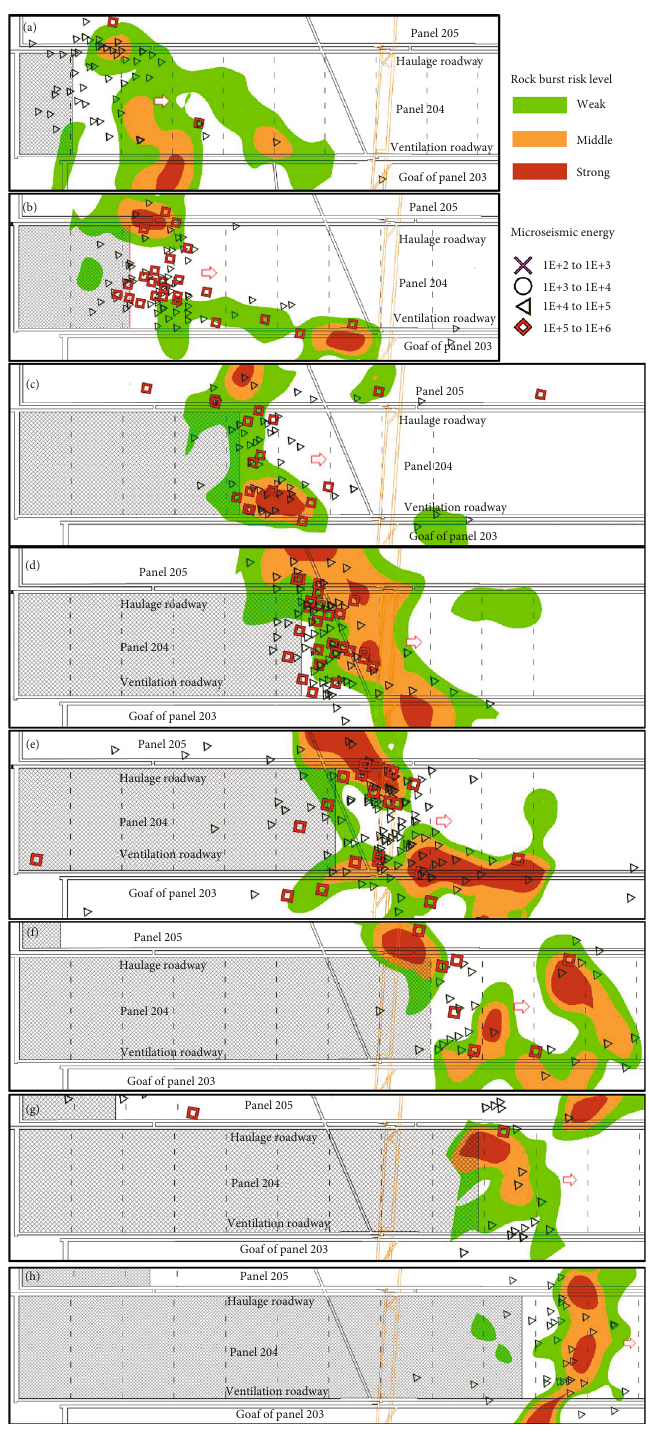
Figure 6: Rock burst risk zones and future seismic events. (a) Burst risk zones on 30 April 2019 and seismic events from 1 to 30 May 2019. (b) Burst risk zones on 31 May 2019 and seismic events from 1 to 30 June 2019. (c) Burst risk zones on 31 July 2019 and seismic events from 1 to 31 August 2019. (d) Burst risk zones on 15 September 2019 and seismic events from 16 to 30 September 2019. (e) Burst risk zones on